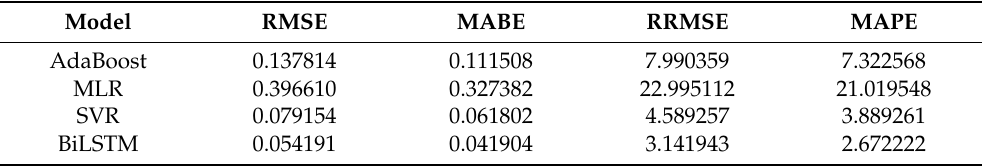
Table 6. Model error metrics for Kiribati.